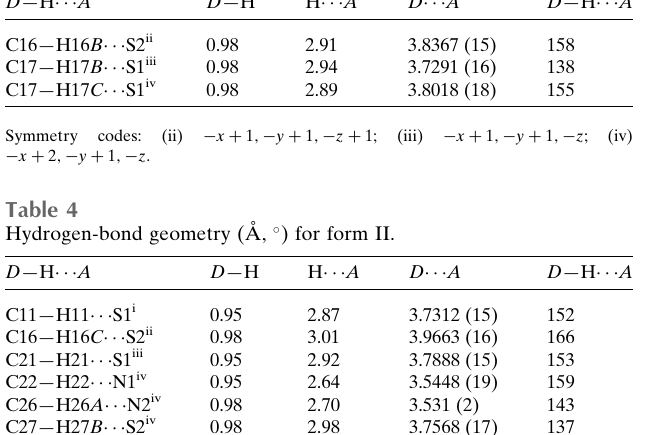
Table 1 Selected geometric parameters (A˚ , (cid:4) ) for form I. Co1—N1